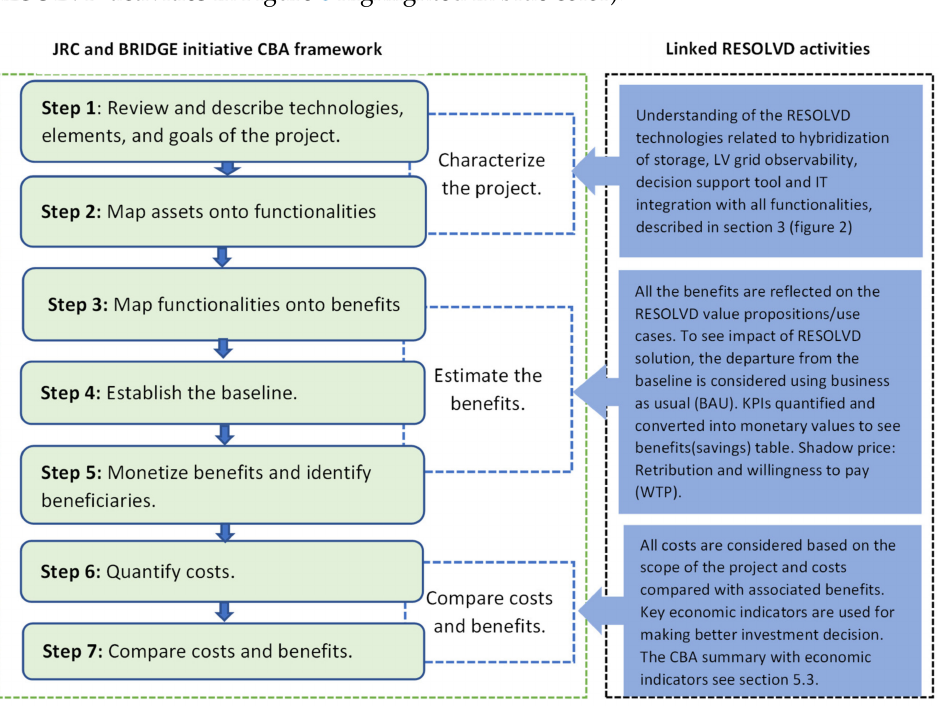
Figure 6. CBA process steps used in RESOLVD are based on the JRC and BRIDGE